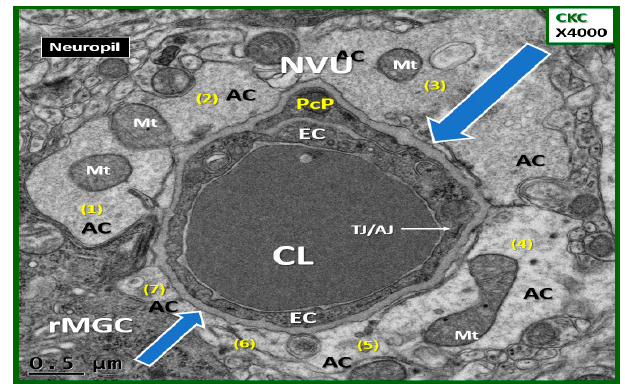
Figure 2. A representative image of the control CKC nondiabetic model with intact adherent astrocytes: This image depicts the astrocyte end-feet foot processes (ACfp) numbering seven (1–7 in yellow) that are tightly abutted and adherent to the basement membrane (BM) (open blue arrows) of the NVU mural endothelial cell(s) (EC) and pericyte end-feet foot processes (Pc). Note the one tight and adherent junction (TJ/AJ) in this cross-sectional image (closed arrow). Magnification ×4000; scale bar = 0.5µm. AC = astrocytes; CL = capillary lumen; EC = endothelial cell; Pc = pericyte; rMGC = ramified microglia cell; NVU = neurovascular unit TJ/AJ = tight junction/adherent junction. Available via license CC BY 4.0.